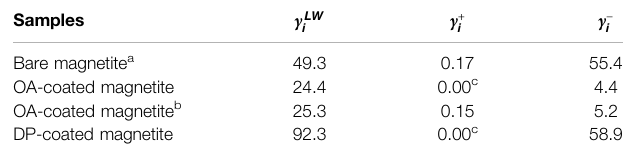
TABLE 2 | The surface free energy components (mJ/m 2 ) of magnetite nanoparticles.